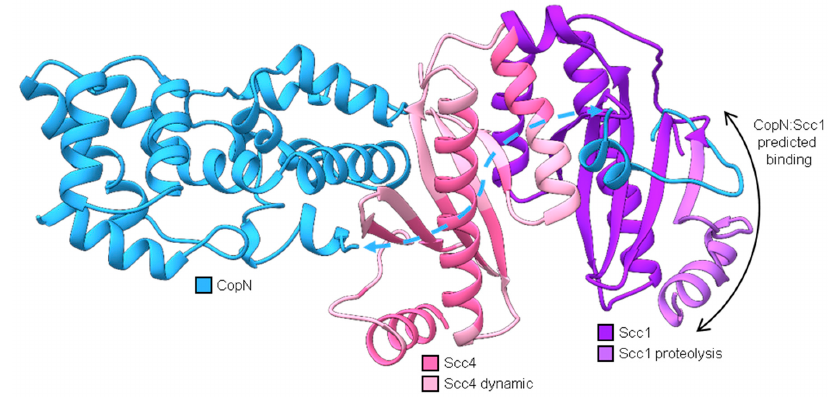
Figure 9. Structural homology models (generated using the protein homology / analogy recognition engine, Phyre2 [26]) of CopN (blue), Scc4 (pink), and Scc1 (purple) aligned on the X-ray structure of Yersinia pestis YopN:SycN:YscB complex (Protein Data Bank code 1XKP) [16,27]. Phyre2 alignments are shown in Figures S10, S11, and S12. Models for CopN include two fragments (residues 37–60 and 77–267), which are connected with a dashed blue arrow. The N -terminal fragment of CopN was predicted to interact with the first beta strand of Scc1 (black double arrow). As part of the Scc4:Scc1 complex, this region of Scc1 (residues 1–31, light purple) was susceptible to proteolytic cleavage [16]. The regions of Scc4 in light pink are residues determined to be dynamic and form random coils in Scc4